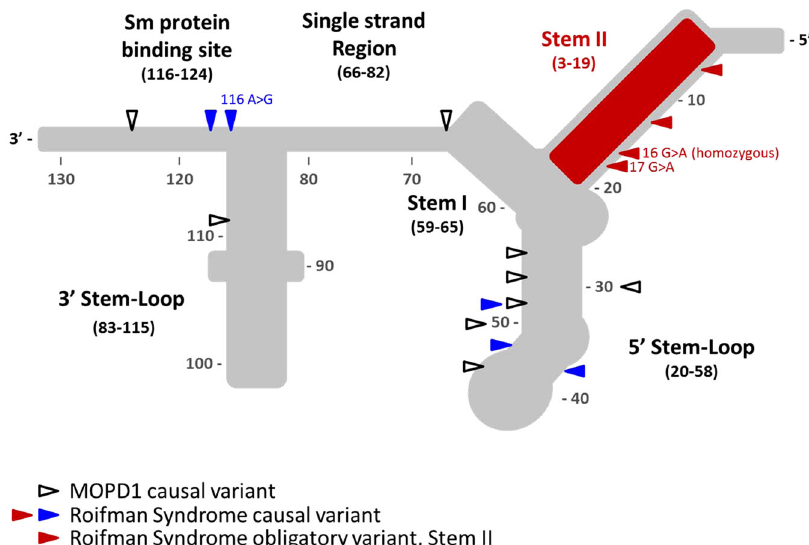
Fig. 1 RNU4ATAC structural elements, and MOPD1 and Roifman syndrome causal variants. Stem I and Stem II are both elements at the 3 ′ and 5 ′ of U4atac, respectively, which base pair with U6atac. These elements are separated by an intramolecular 5 ′ stem-loop. Another stem loop is located at the 3 ′ end of U4atac. The Sm protein binding site is important for binding of the Sm proteins, which are important for the assembly of the complex and its import into the nucleus. The Stem II, Stem I, 5 ′ stem-loop and Sm binding site are all highly conserved. Delineated in red is the Stem II domain, which is obligatory for the pathogenesis of Roifman syndrome. Adapted from refs. 9,